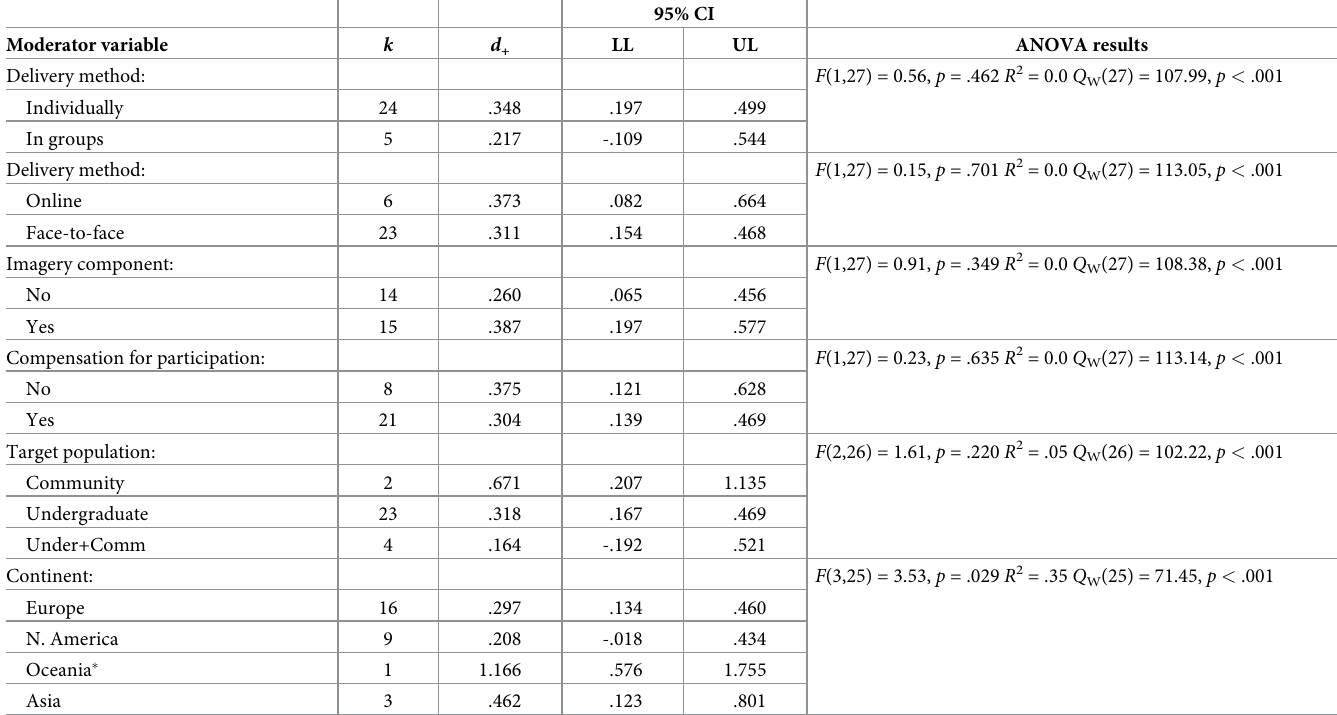
Table 6. Results of the weighted ANOVAs of categorical moderator variables on the effect sizes for